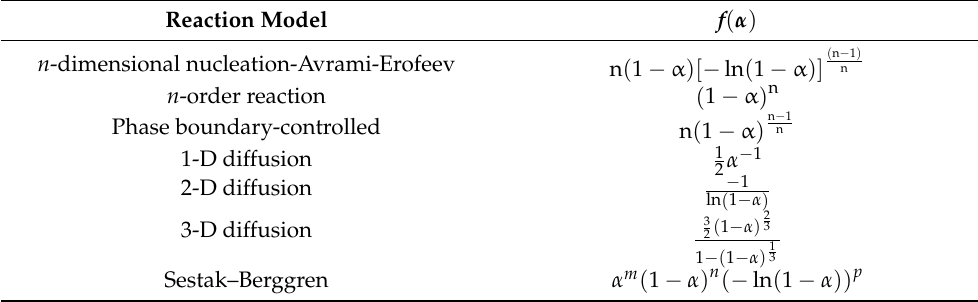
Table 5. Common reduction functions reported in the literature. Reaction